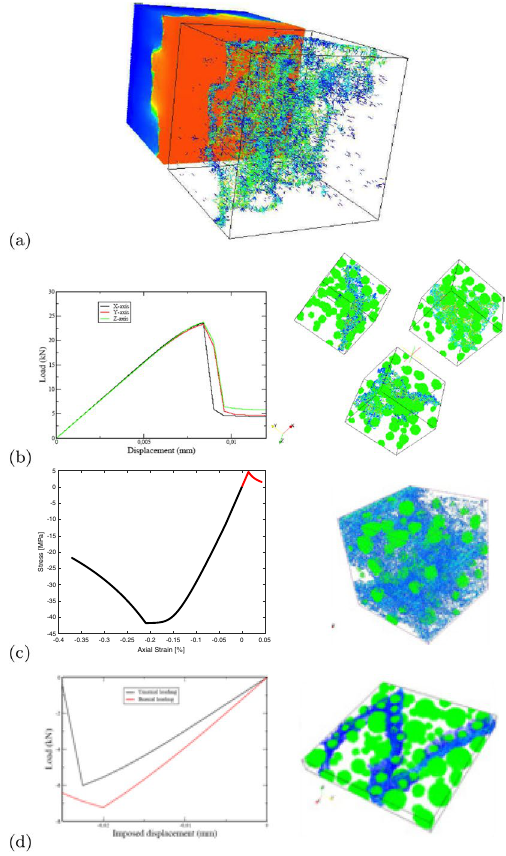
Fig. 13 Meso-scale model computational results: a simple tension test: displacement contours or broken cohesive links [31]; b con- crete as (statistically) isotropic material: tension test results in 3 orthogonal directions; c uniaxial compression force-displacement and failure mode with cohesive links failure; d biaxial compression (confirming compressive strength increase from uniaxial case) and failure